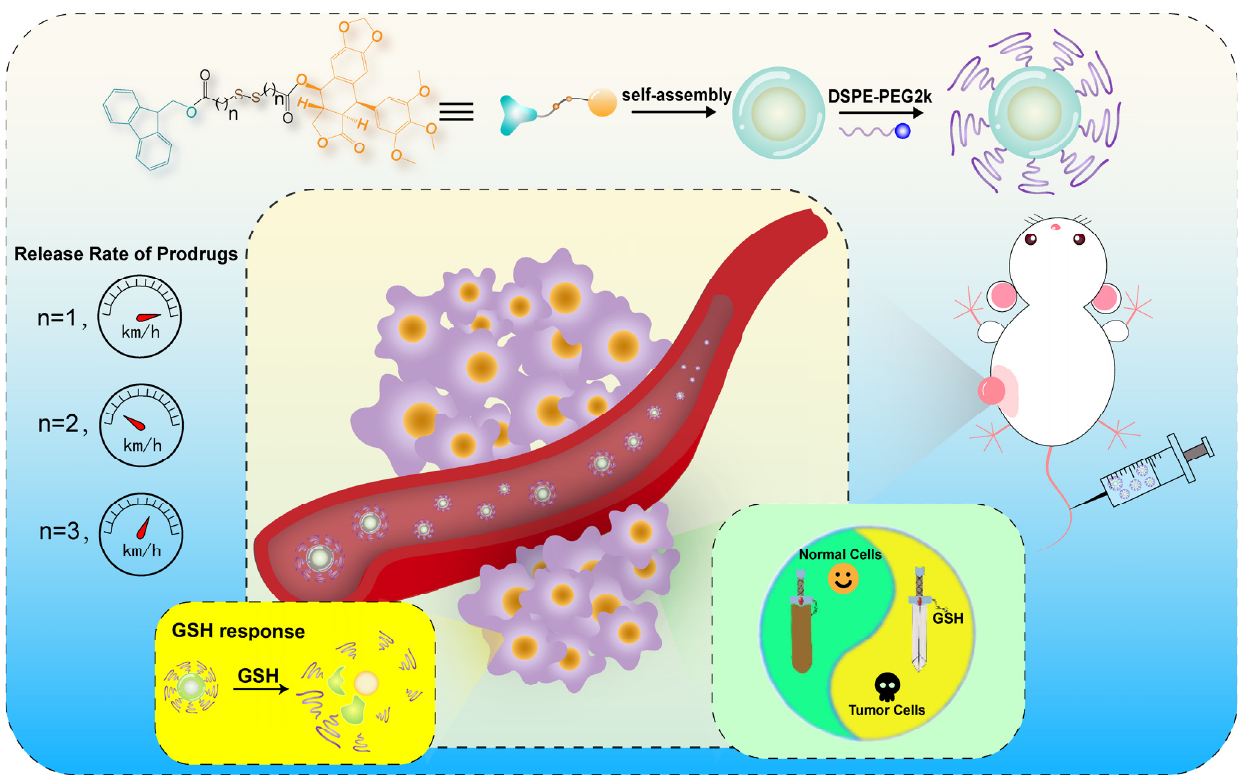
Scheme 1. Schematic illustration of the podophyllotoxin prodrug NPs and the reduction-responsive drug release in tumor